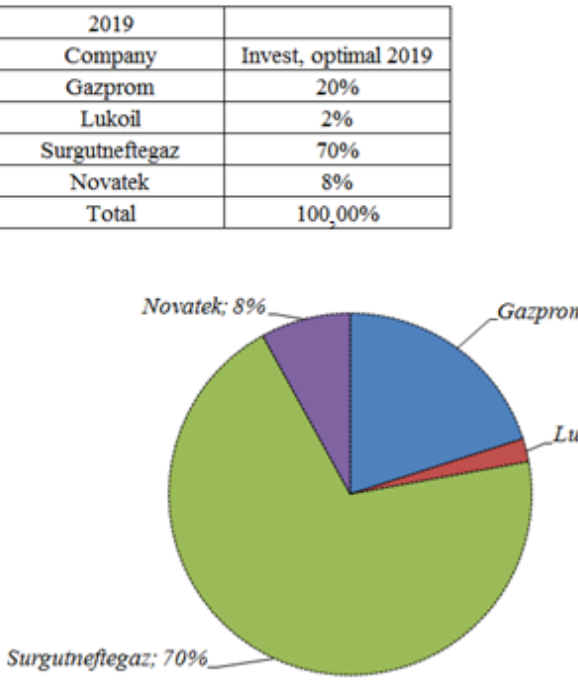
Figure 3. Optimal capital by model (6)–(7).